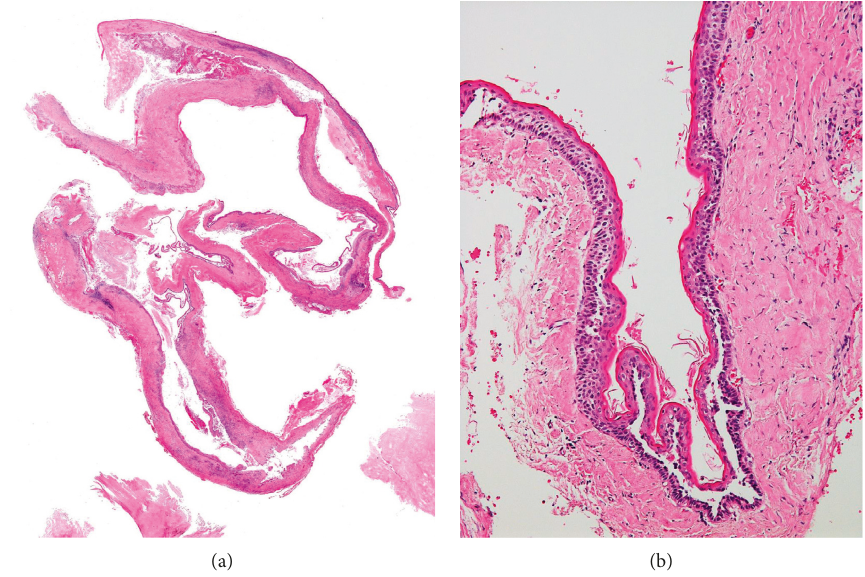
Figure 3: Microscopic features of the biopsy specimen. (a) Survey view of the biopsy specimen. (b) The cyst wall lined by a folded, thin, regular parakeratinized epithelium without rete ridges, and the basal layer lined by palisaded columnar cells with hyperchromatic nuclei (HE; original magnification: × 12.5 (a) and × 100 (b)).